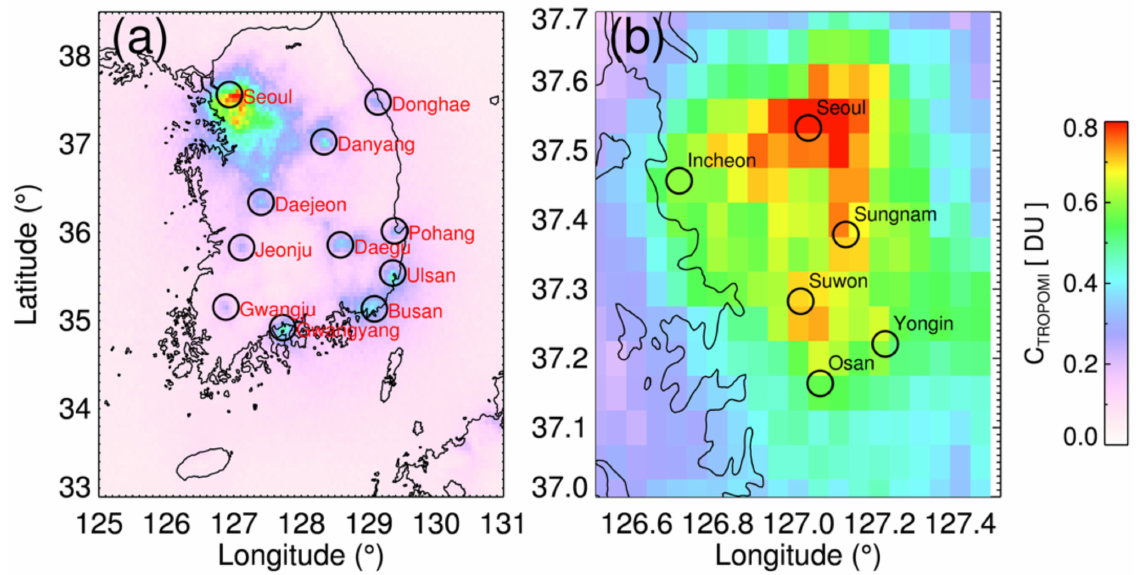
Figure 2. Average TROPOMI NO 2 tropospheric columns for 2019 binned to a 0.05 ◦ × 0.05 ◦ horizontal grid over ( a ) South Korea and ( b ) Seoul metropolitan area. TROPOMI NO 2 data with quality flag greater than 0.75 are used to calculate the average values to avoid cloud contaminations. Black circles in panel ( a ) show major NO 2 sources in South Korea.